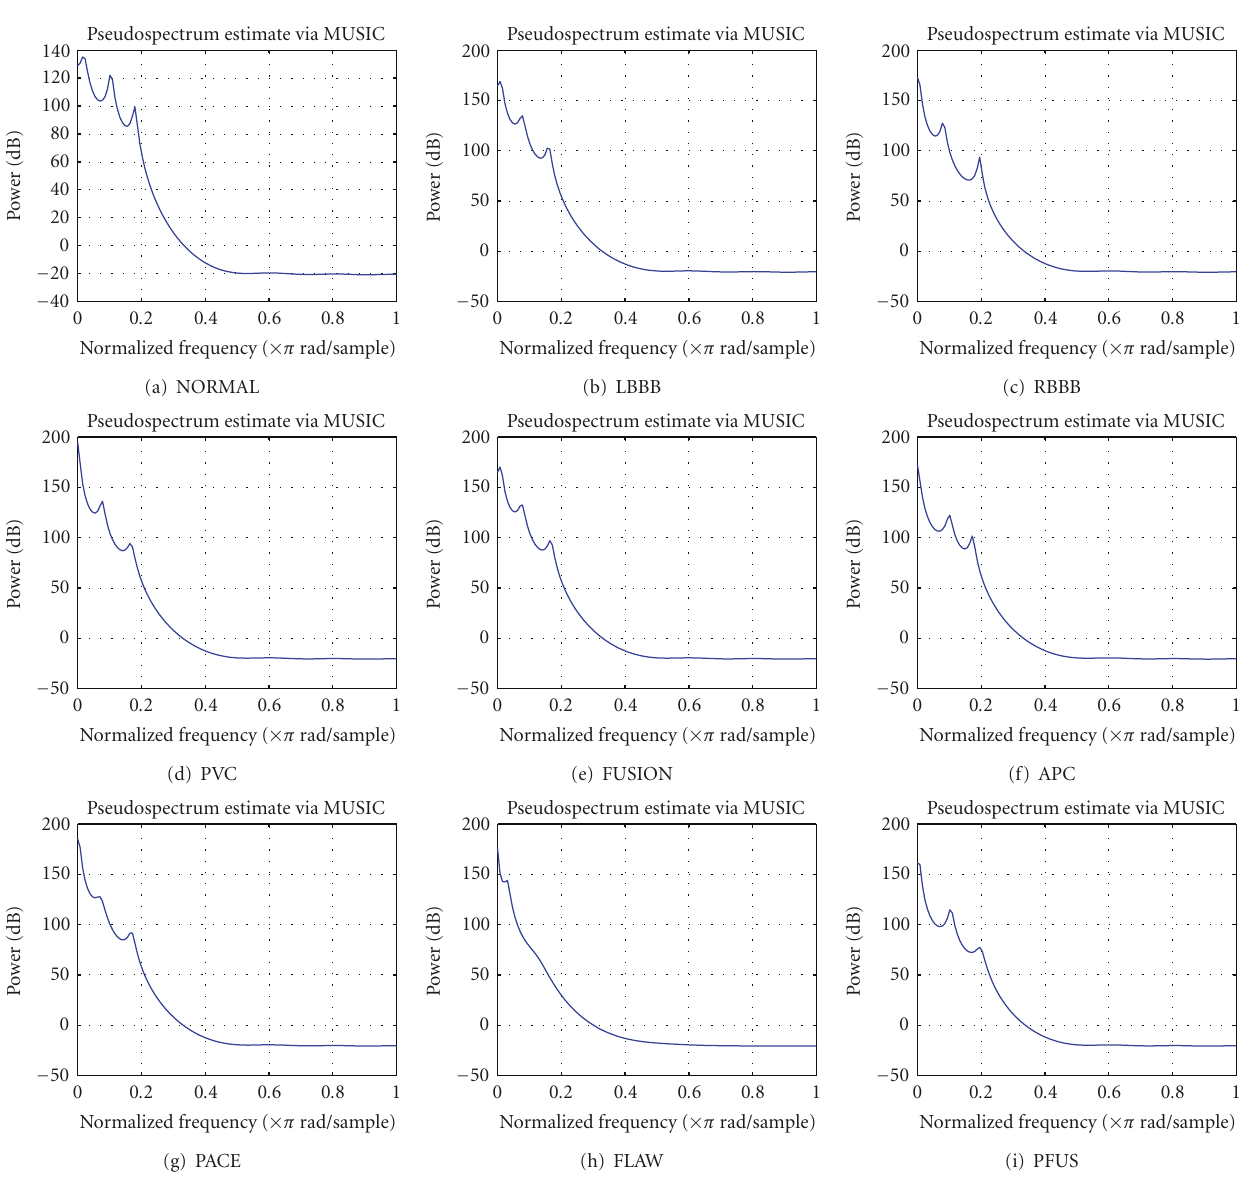
Figure 3: Pseudospectrum of each class which was estimated by MUSIC